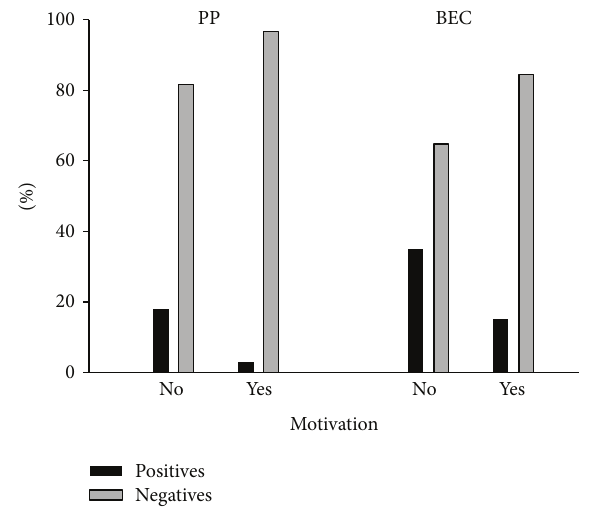
Figure 2: Distribution of positivity divided by site and motivation for the oral